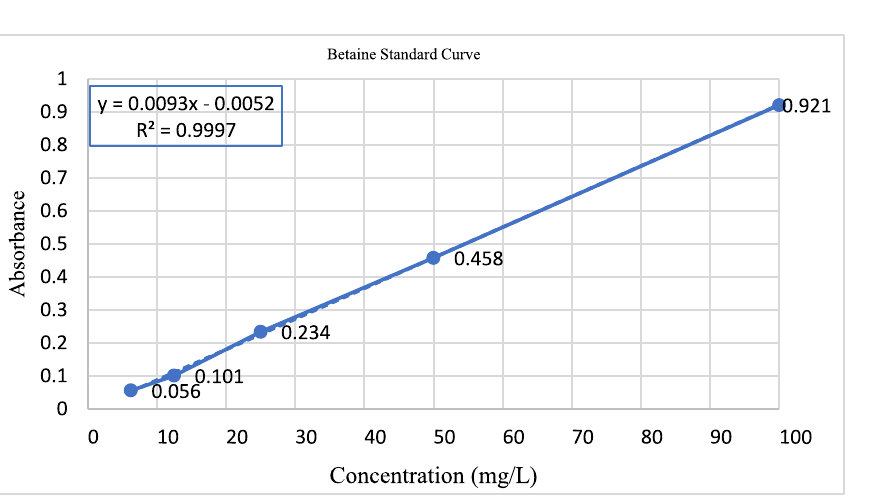
Fig. 9. Betaine estimation through standard curve analysis and concentration of standard were plotted against observance